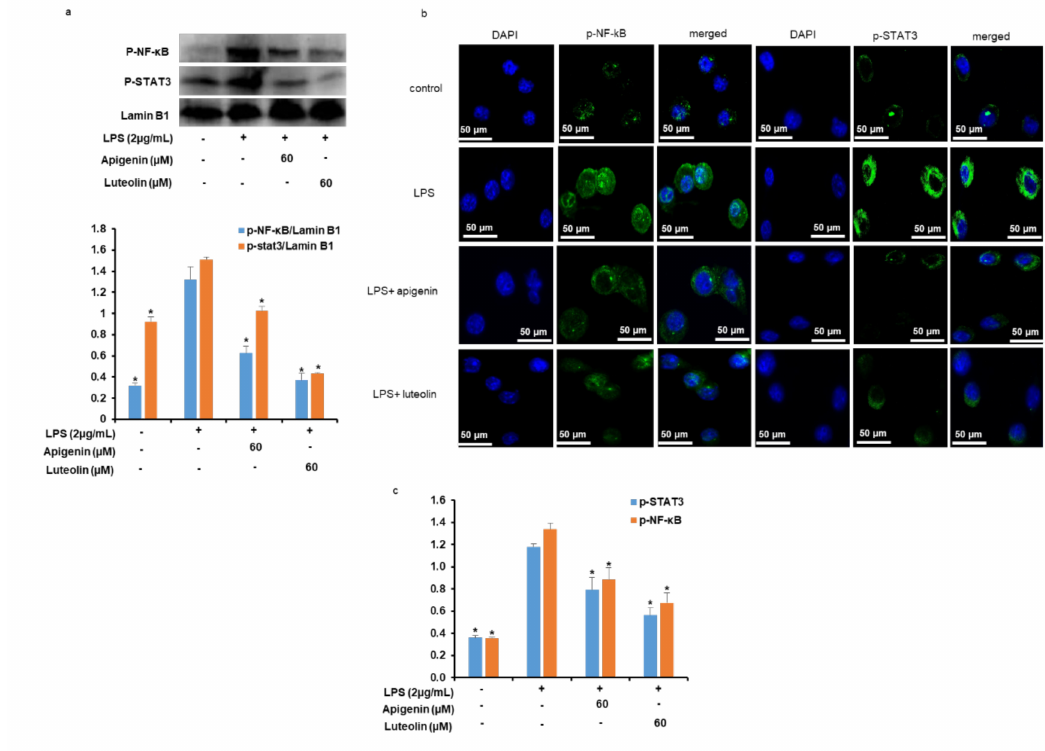
Figure 6. Apigenin and luteolin inhibited the nuclear translocation of NF- κ B and STAT and their DNA binding activities. Microglia cells (5 × 10 5 cells / mL) were cultured and pre-treated with apigenin or luteolin before the cells were stimulation with LPS for 30 min. The protein expression levels of activated NF- κ B and STAT in nuclear extract were investigated by western blot assay and the band densities were analyzed using ImageJ analysis software, with respect to lamin B1 ( a ). The expression of activated NF- κ B and STAT translocation to the nucleus of microglial were investigated by immunofluorescence at × 40 magnification ( b ). The DNA binding activities of activated NF- κ B and STAT were evaluated in the nuclear extracts using the ELISA-based method ( c ). Where applicable, the results are presented as the mean ± SD ( n = 3). The asterisk (*) indicates a significant di ff erence at * p < 0.05 compared to the LPS-only treated cells for bars with the same